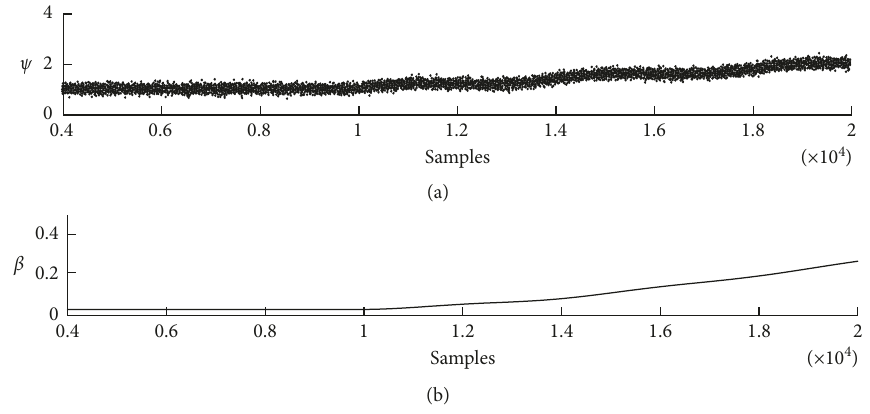
Figure 4: Comparison of the trends of (a) the raw indicator ψ and (b) the proposed indicator β in the case of simulated signal reported in Figure